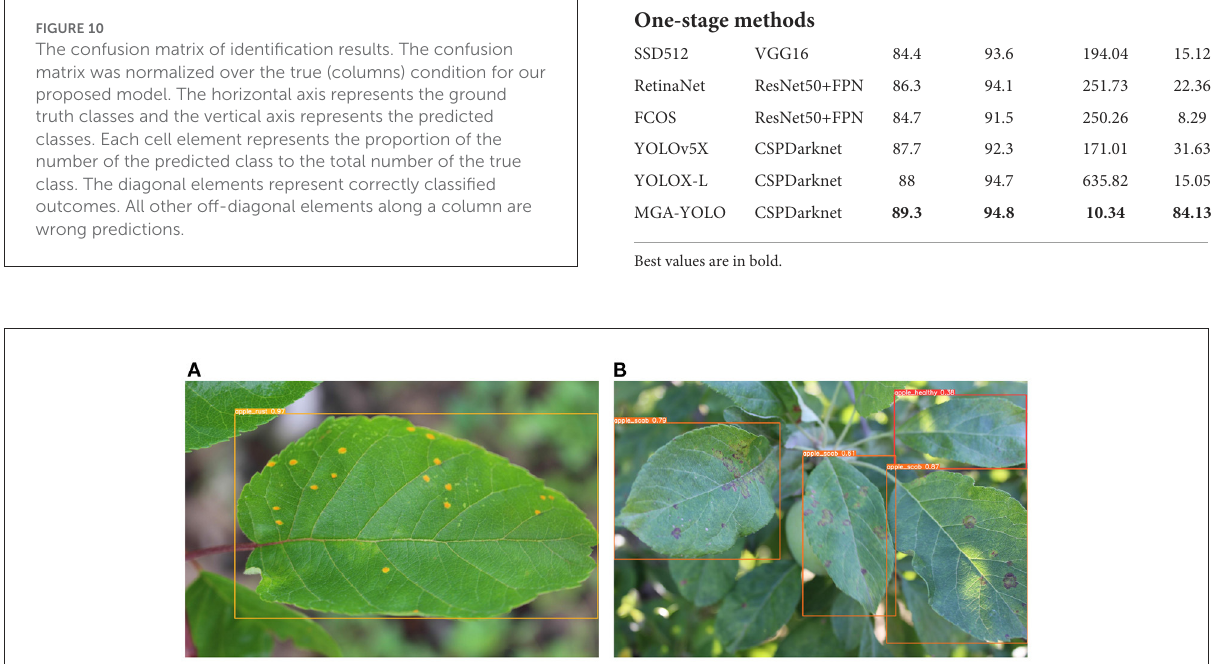
FIGURE11 Examples of apple leaf disease detected by MGA-YOLO. (A) A leaf infected with rust is detected. (B) Three leaves infected with scab and a healthy leaf are detected. Each predicted bounding box shows the predicted label of the detected leaf and the confidence of the predicted